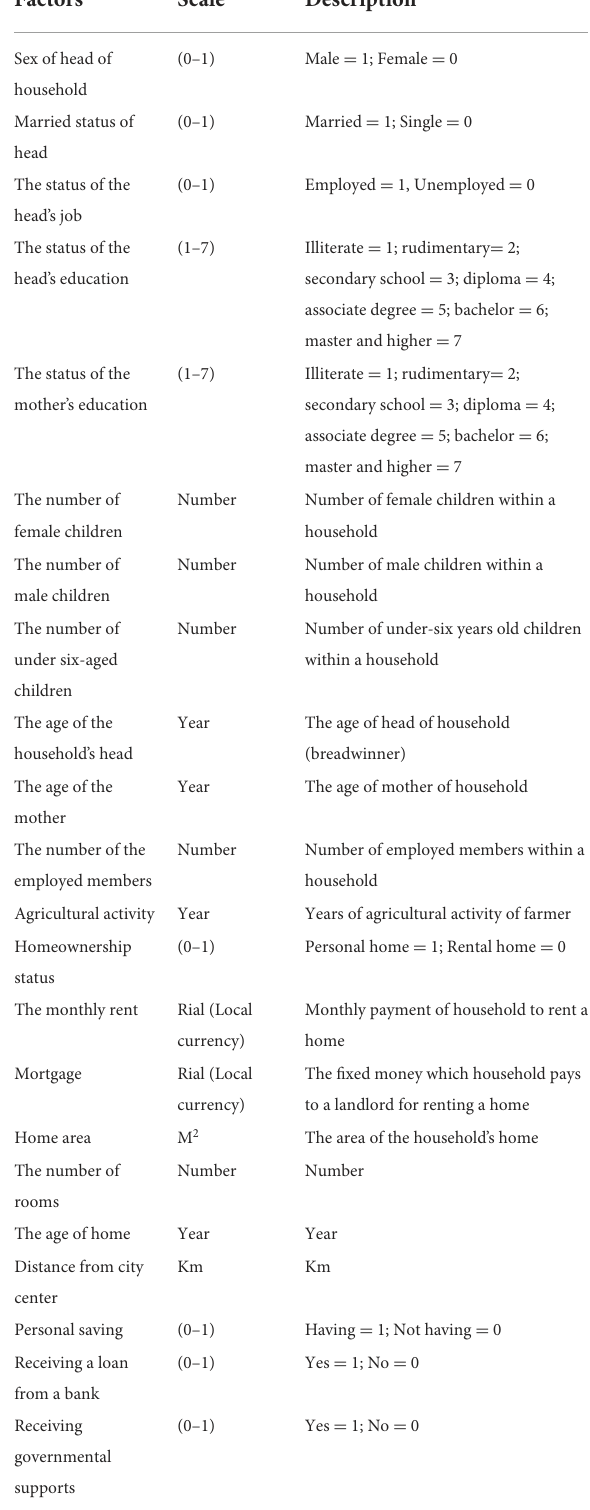
TABLE 3 The description of all used factors in the Tobit regression